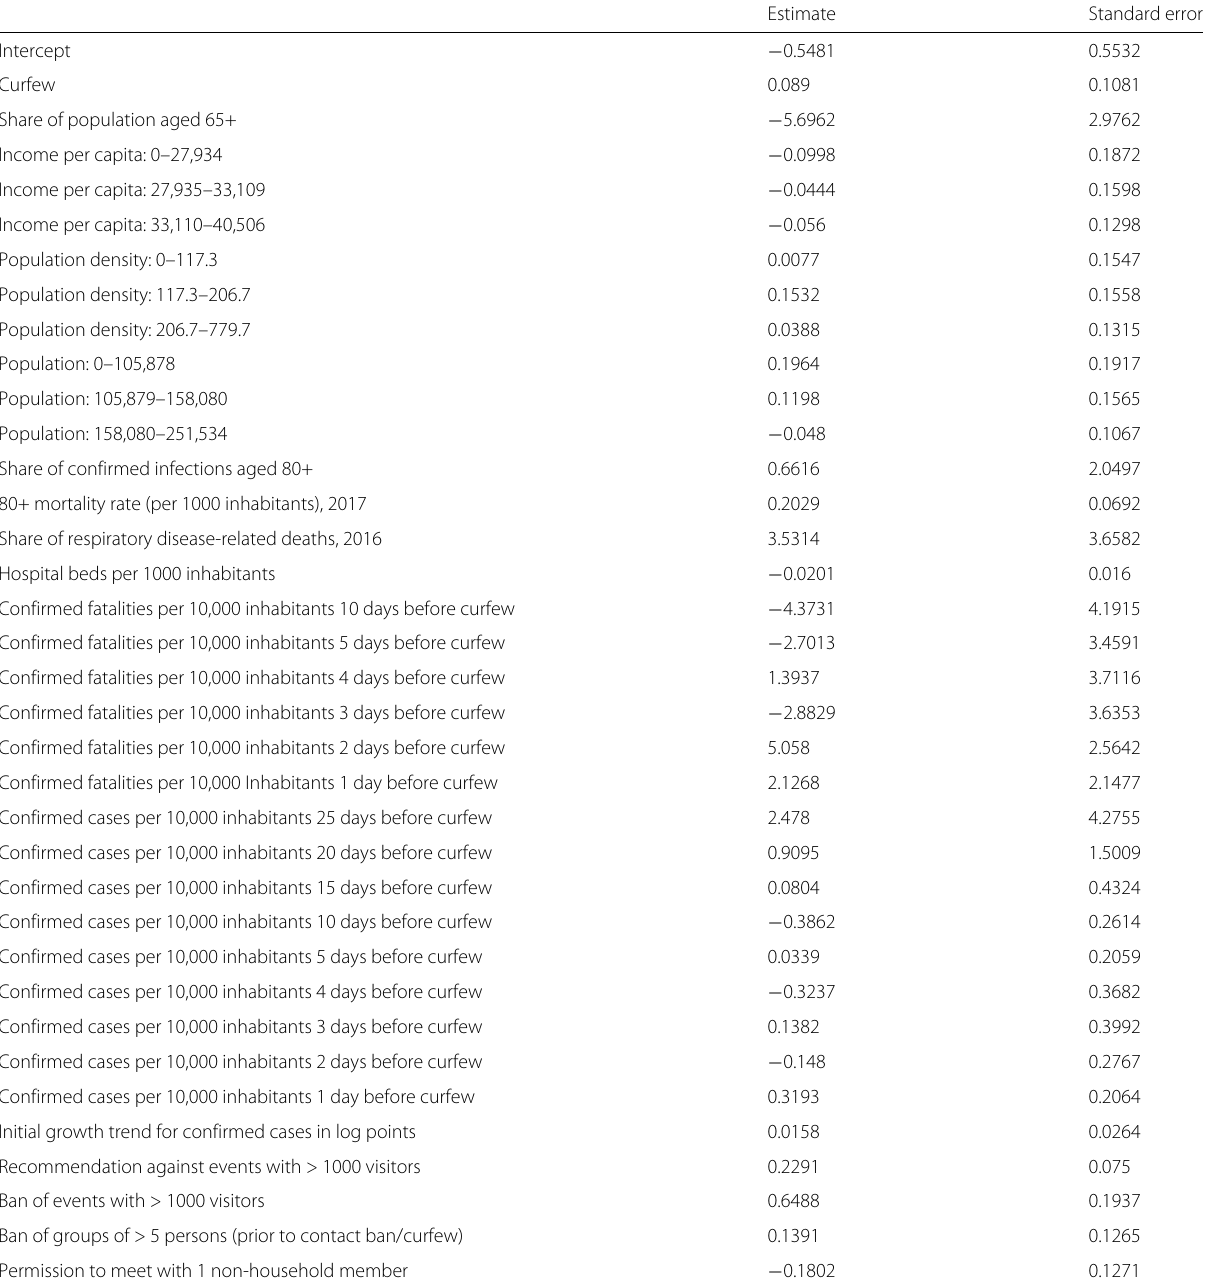
Table 6 OLS estimates for the impact of curfews (compared to contact restrictions) 35 days after the imposition of curfews with fatalities per 10,000 inhabitants as outcome variable